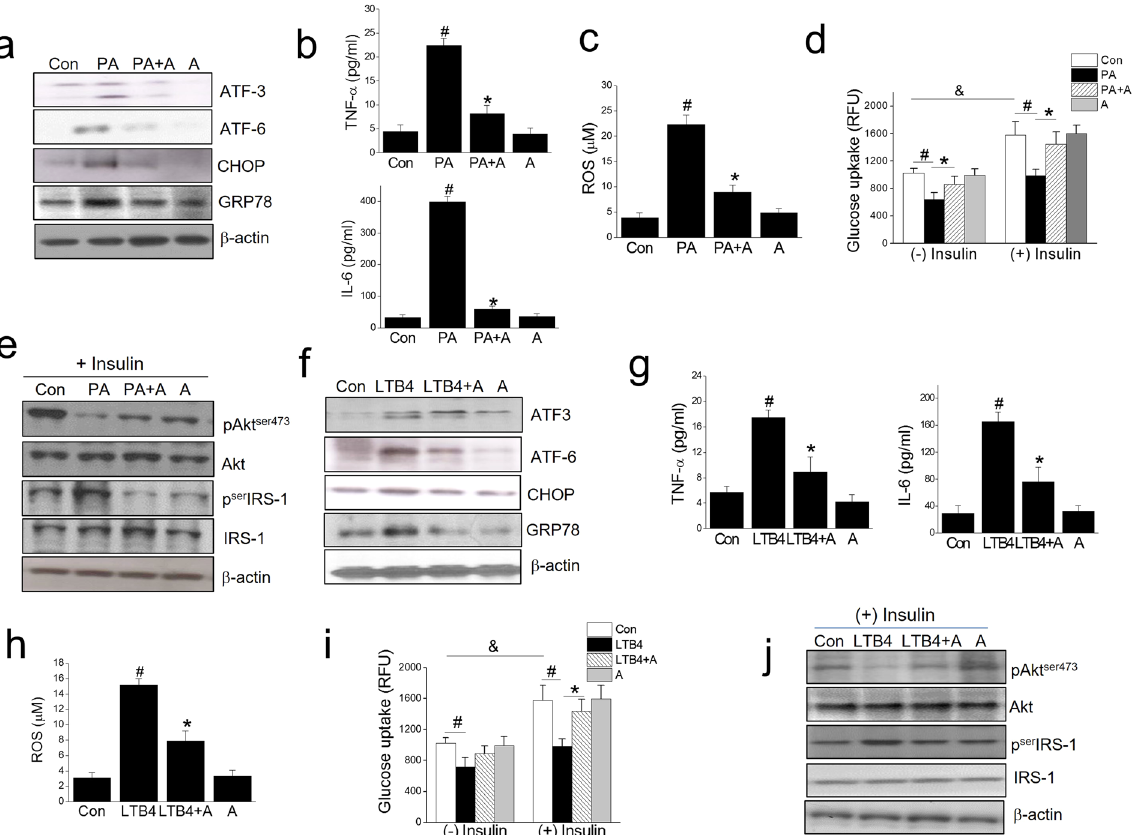
Figure 8. The effect of an AMPK activator, A769662, on the PA and LTB4 actions. Differentiated C2C12 myotubes were exposed to A769662 (80 μ M) for 1 h and then treated with either PA (750 μ M) or LTB4 (100 ng/ ml) in the presence of A769662 for 12 h (qPCR) or 24 h (ELISA). Levels of ER stress markers were determined by western blotting ( a and f ). Levels of pro-inflammatory cytokines were determined by ELISA ( b and g ). ROS production was assessed using AmplexRed ( c and h ). After 24 h of PA treatment, insulin (1 μ g/ml) was added for 30 min, and then glucose uptake was determined by 2-NBDG ( d and i ). Akt and serIRS-1 phosphorylation was assessed by western blotting ( e and j ). The results of the western blotting are shown as the representative of three independent experiments ( a , e , f , j ), and other results are expressed as the means ± SDs of three experiments performed in triplicate. # P < 0.05 vs . non-treated controls, * P < 0.05 vs . PA or LTB4 alone, & P < 0.05 vs . ( − )